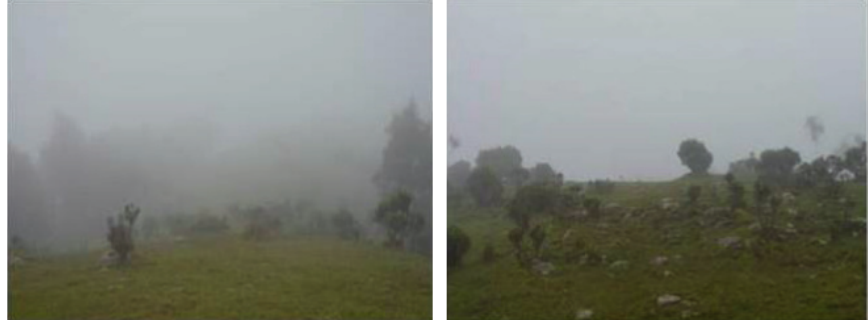
Figure 2: The sub-Afroalpine (Erica scrubland) habitat at Geremba Mountain (photo: Zerubabel Worku, 2018).